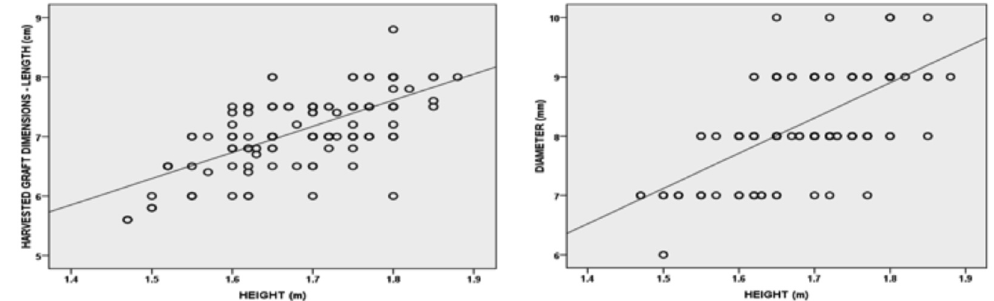
Graph showing positive correlation between patients height vs graft length (R=0.66, p value<0.00001) and graft diameter Fig. 2: (R=0.64, p value<0.0001).